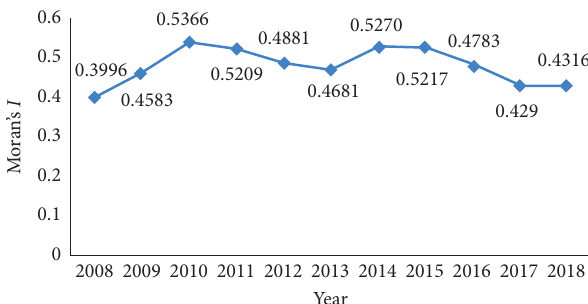
Figure 3: The evolution of Moran’s Ι index from 2008 to 2018.